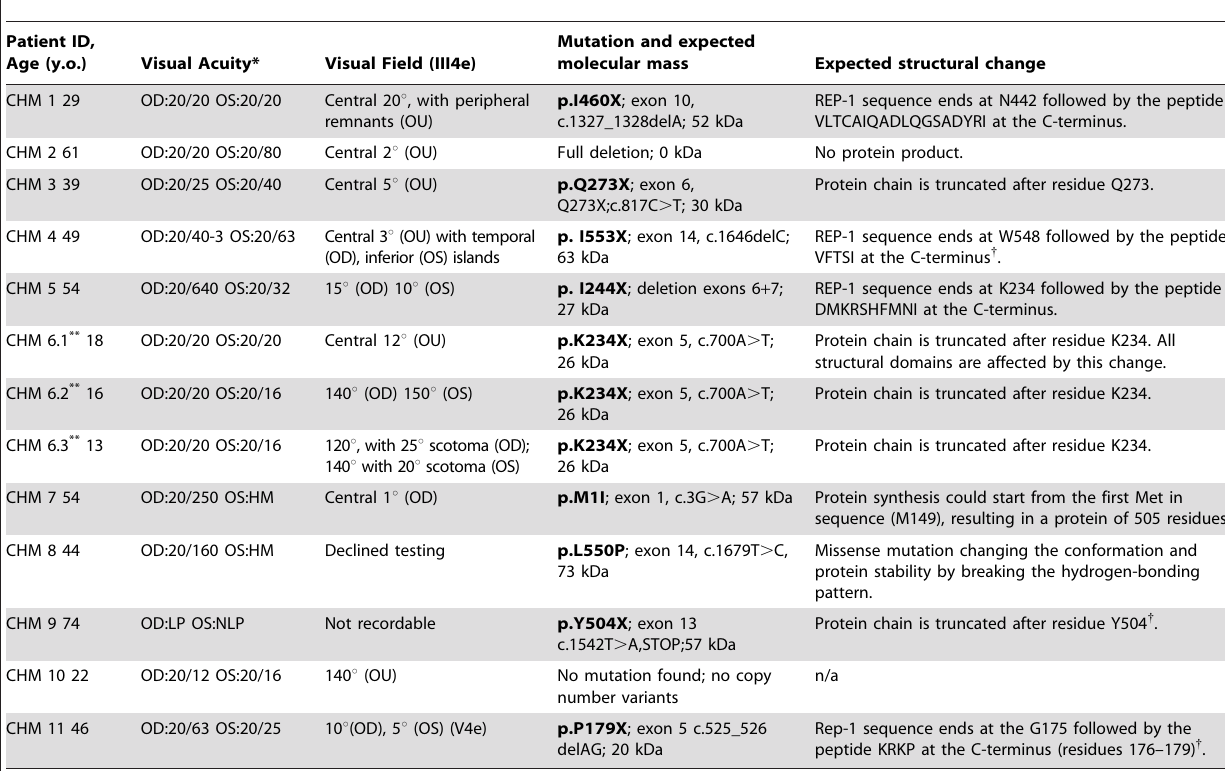
Table 1. Clinical characteristics of CHM patients and expected effect of determined mutations on the structure of REP-1 protein.